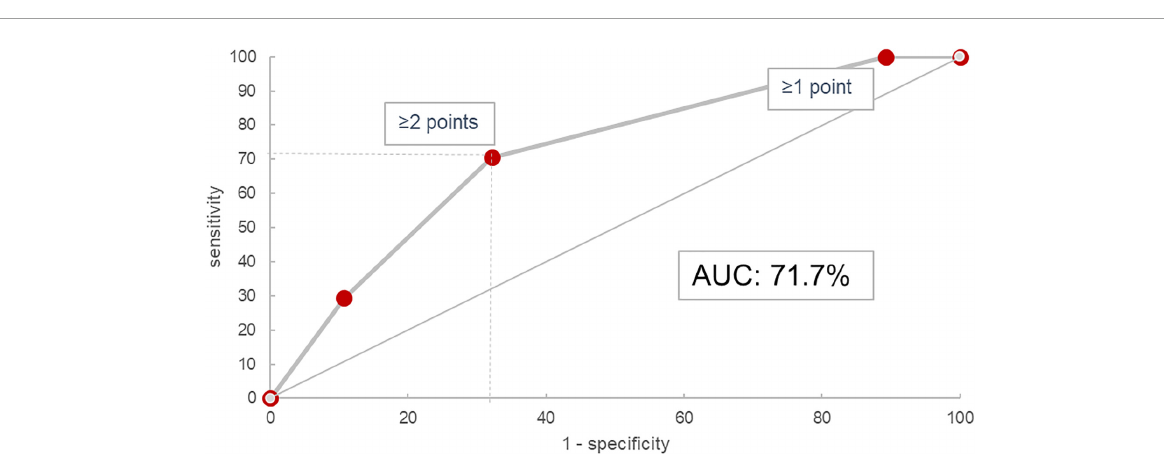
FIGURE5 Receiver operating characteristic curve for the HTM score in the validation cohort. AUC, area under the